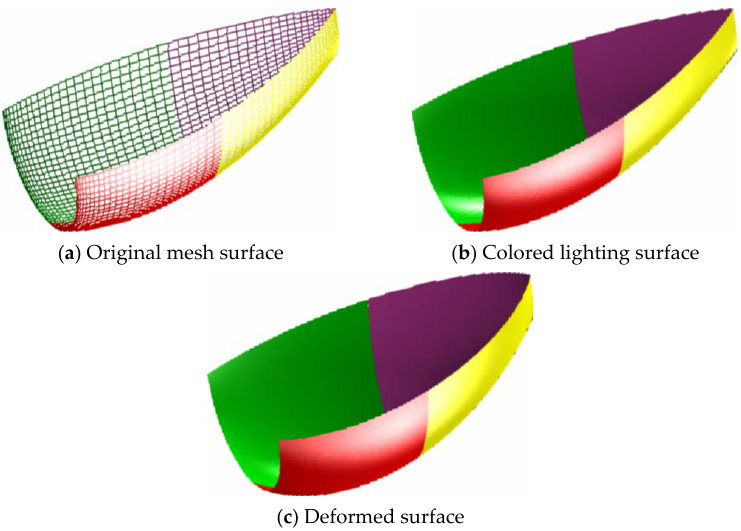
Figure 13. Designing the surface model of a ship hull.